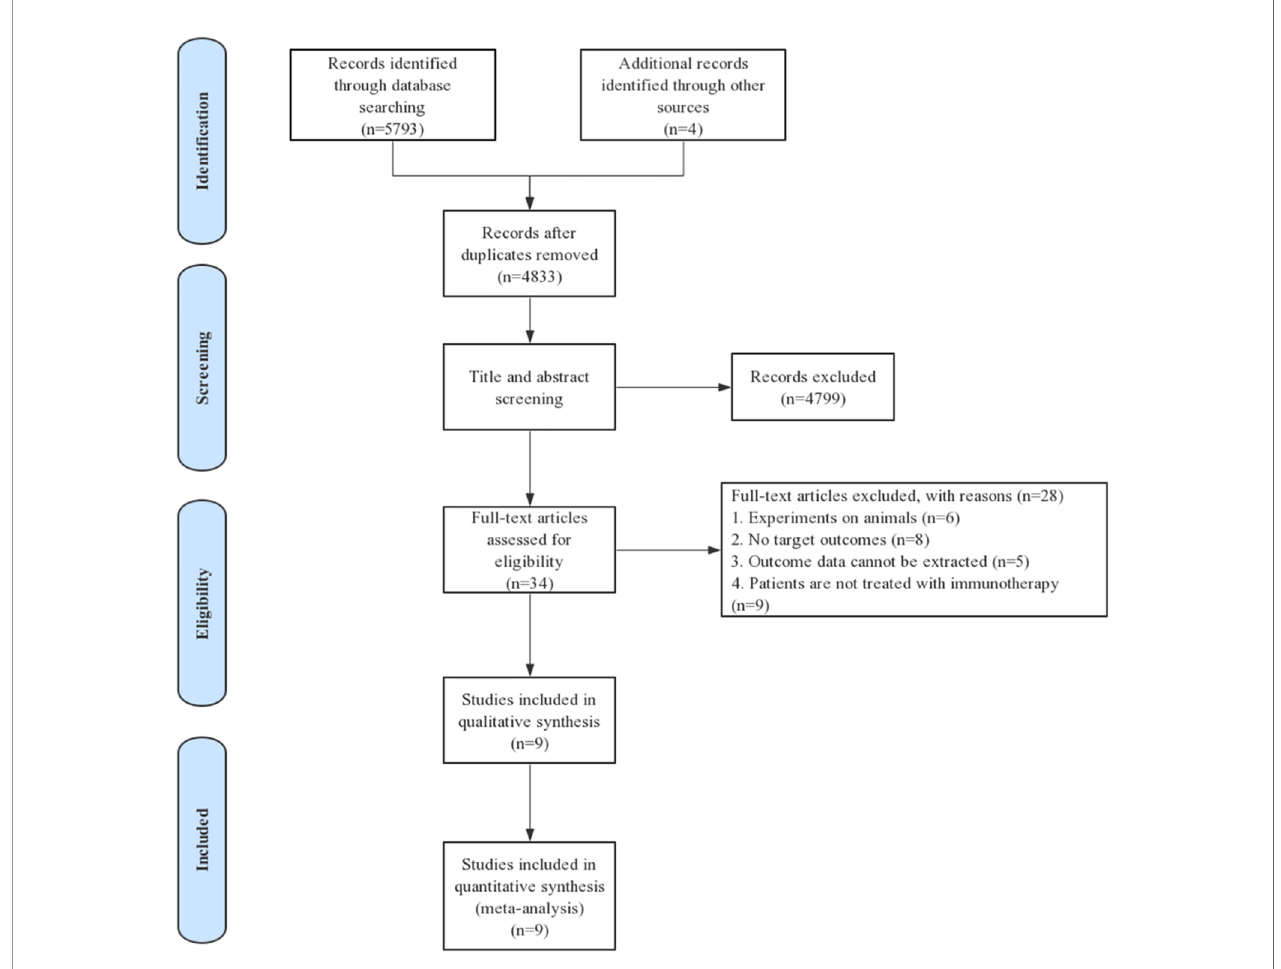
FIGURE 1 | PRISMA fl ow diagram detailing the search strategy and